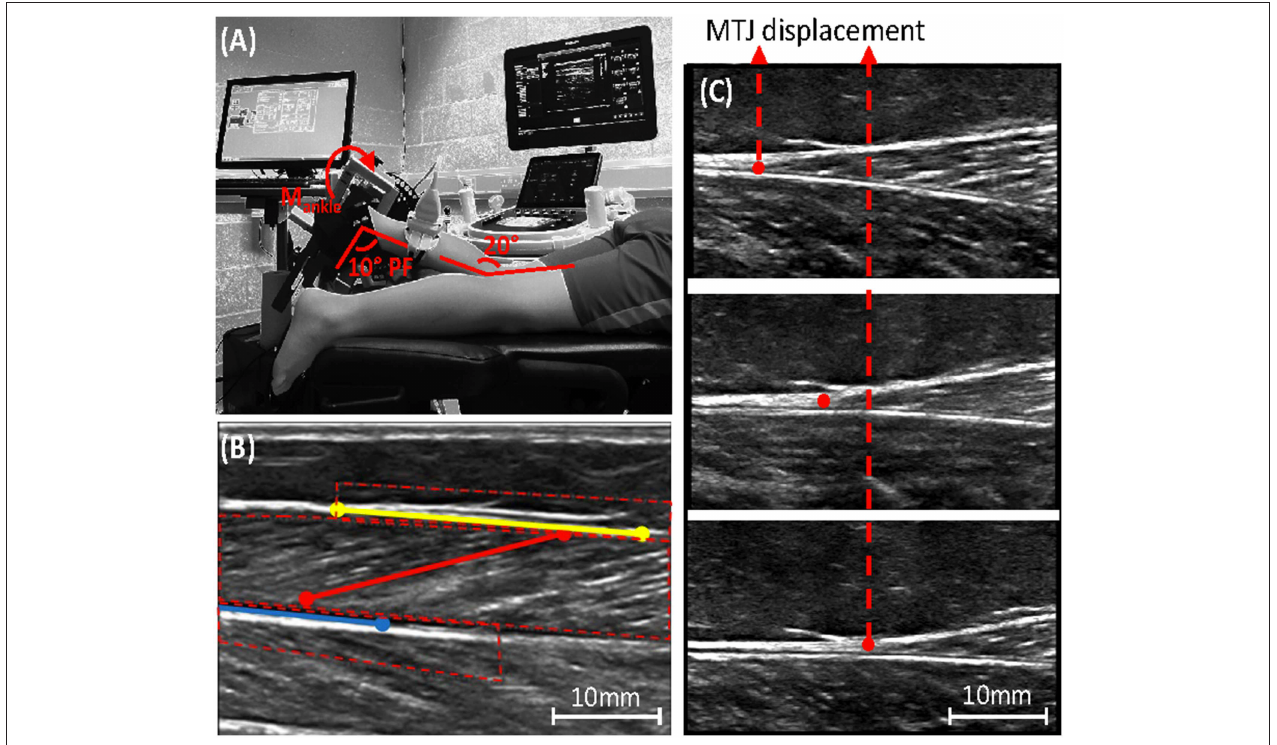
FIGURE 2 | (A) Experimental set-up, showing leg placement in the dynamometer combined with ultrasound placement over the medial gastrocnemius muscle-tendon-junction (MTJ). (B) Ultrasound image of the medial gastrocnemius with the defined range of interest needed to track fascicle length (red), the upper (yellow), and lower (blue) aponeurosis; see online version for color. (C) Ultrasound image showing medial gastrocnemius MTJ displacement during muscle